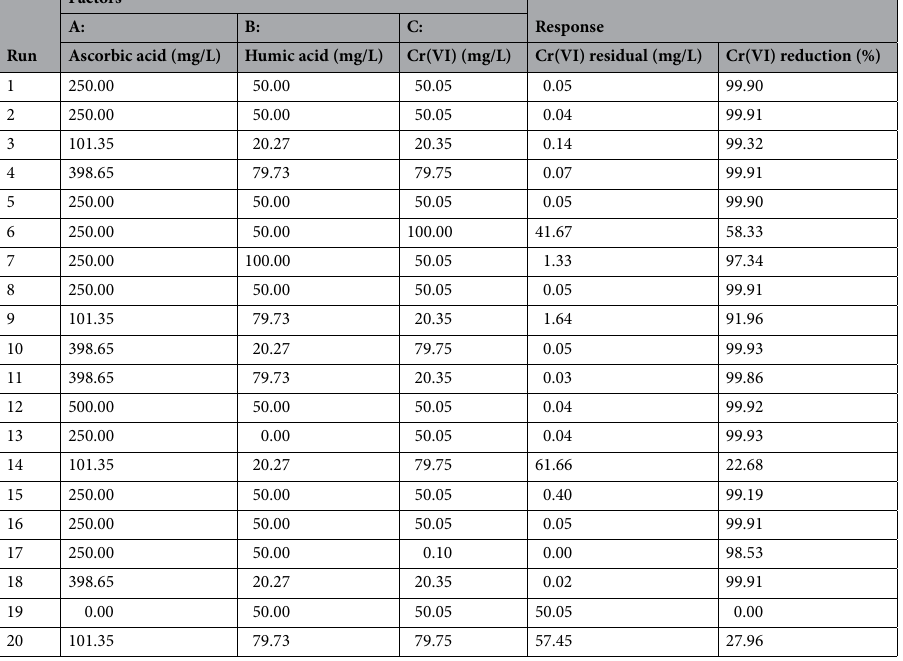
Table 2. Experimental design matrix and the response of experimental settings for the reduction of Cr(VI) using ascorbic acid.